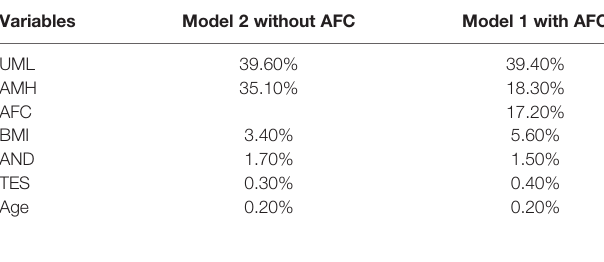
TABLE 3 | Comparison of the main effects of each variable in Models 1 and 2.